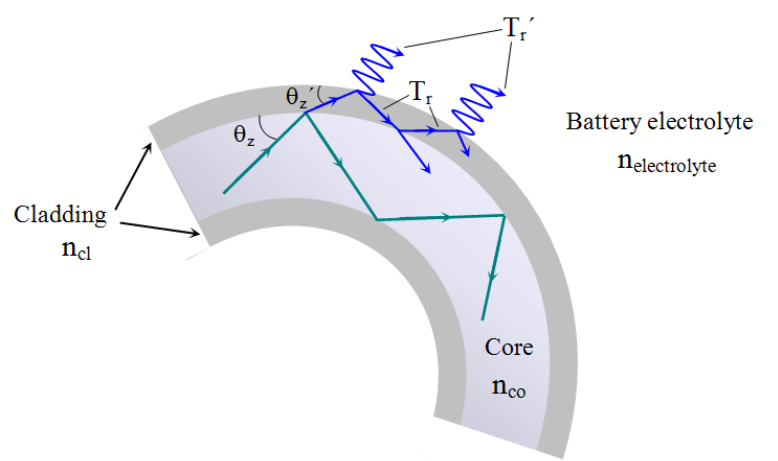
Figure 2. Loss of power taking into account the thickness of the